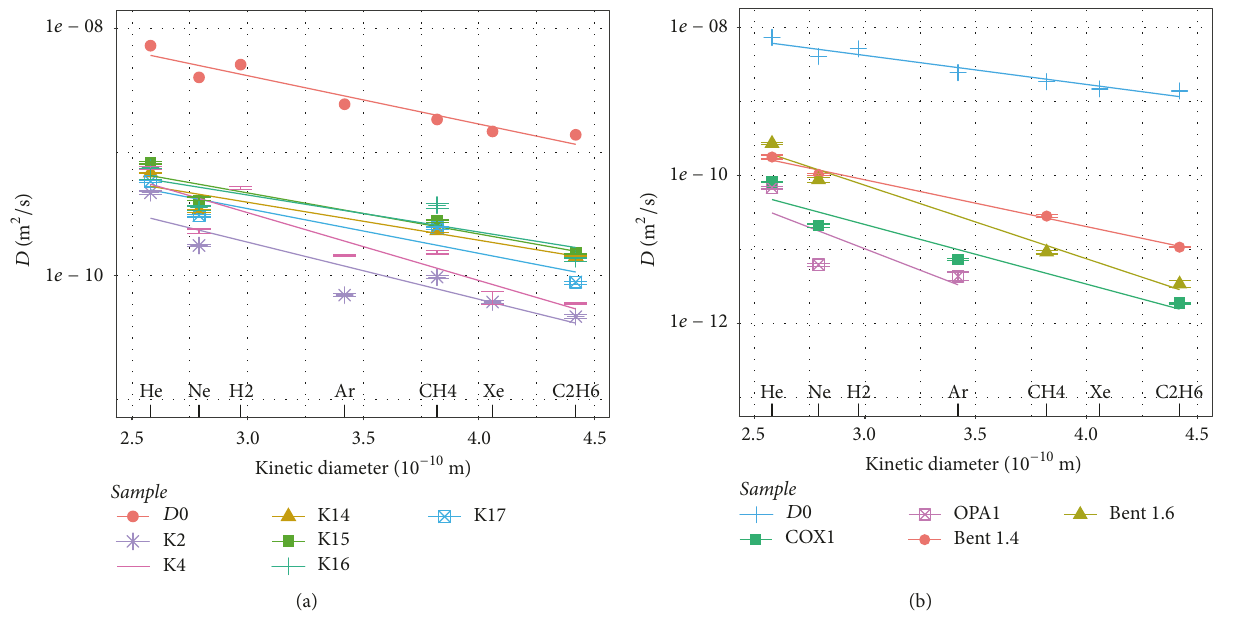
Figure 2: Effective diffusion coefficients for dissolved gases in Boom Clay (a) and other clayey materials (b), fitted with expression (14). The diffusion coefficient D is either the diffusion coefficient D 0 in pure water or the effective diffusion coefficient 𝐷 eff in a porous medium.